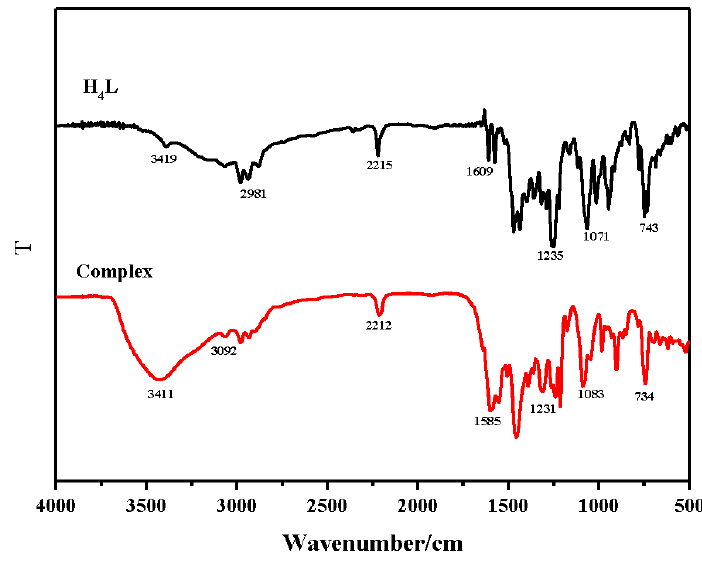
Figure 1. Infrared spectra of H 4 L and its Co(II) complex.